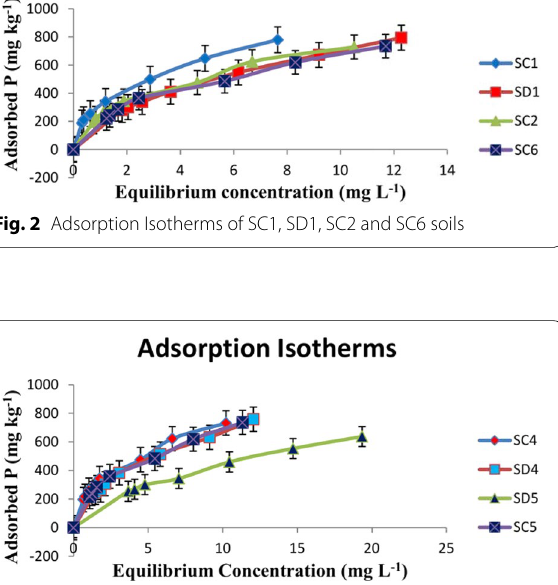
Fig. 3 Adsorption Isotherms of SC4, SD4, SD5 and SC5 soils